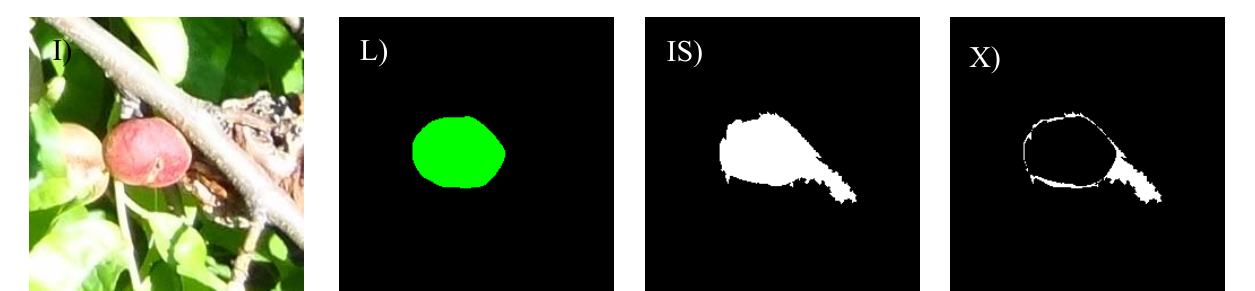
Figure 9. Worst bright illumination image case